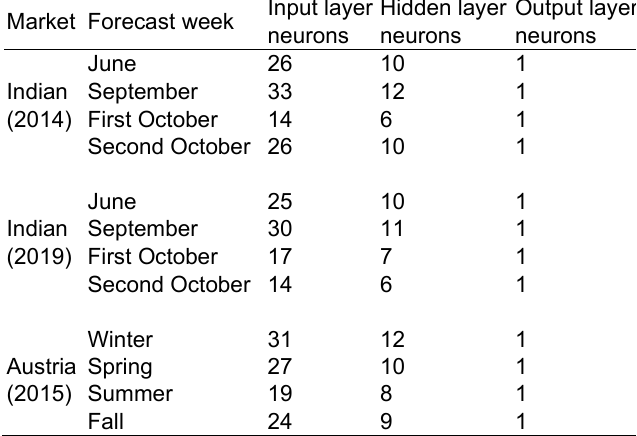
Market Forecast week